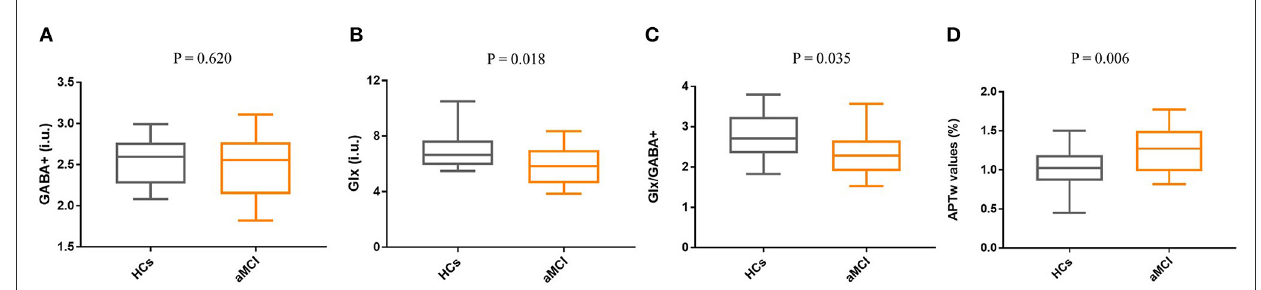
FIGURE4 Box and whisker plots for the comparison of Glx levels, GABA + levels, Glx/GABA + ratios, and APTw values between the HCs group ( n = 20) and the aMCI group ( n = 20). (A) No significant difference in GABA + levels was found between HCs and aMCI ( P = 0.620). (B) Compared with the HCs group, Glx levels of the aMCI group were significantly decreased ( P = 0.018). (C) The Glx/GABA + ratios of the aMCI group are lower than the HCs, and a statistical difference was detected ( P = 0.035). (D) Compared with HCs, patients with aMCI showed higher APTw values in the right hippocampus ( P = 0.006).